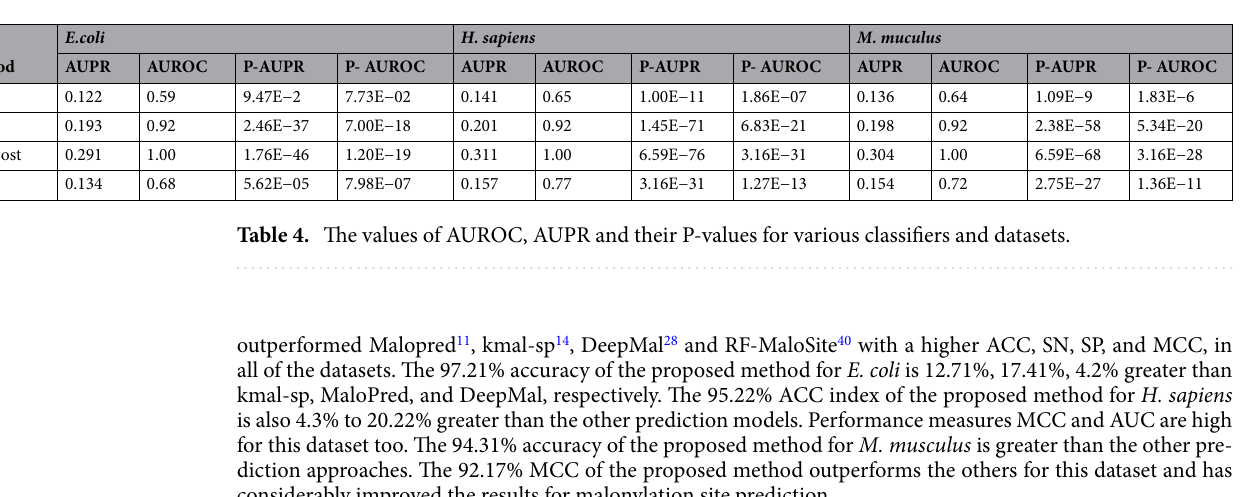
Figure 5. The ROC curve for the proposed method. ( A ), ( B ) and ( C ) diagrams pertain to M. musculus , E. coli , and H. sapiens datasets, respectively.